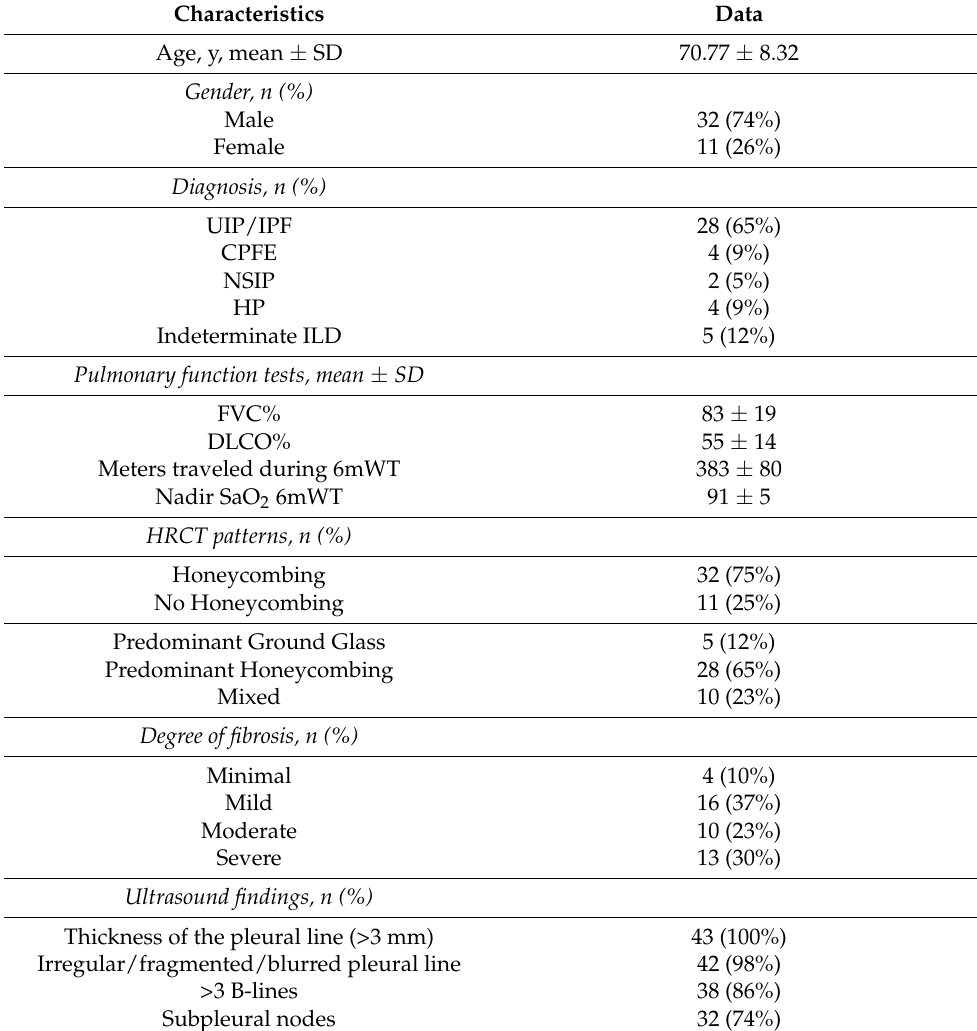
Table 1. Characteristics of the 43 patients in the